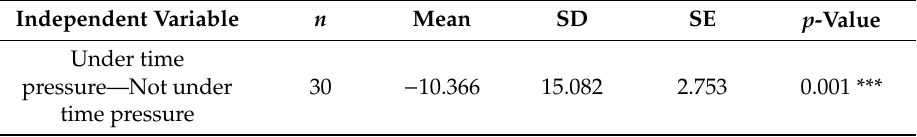
Table 5. Paired t -test results for the number of products viewed between two